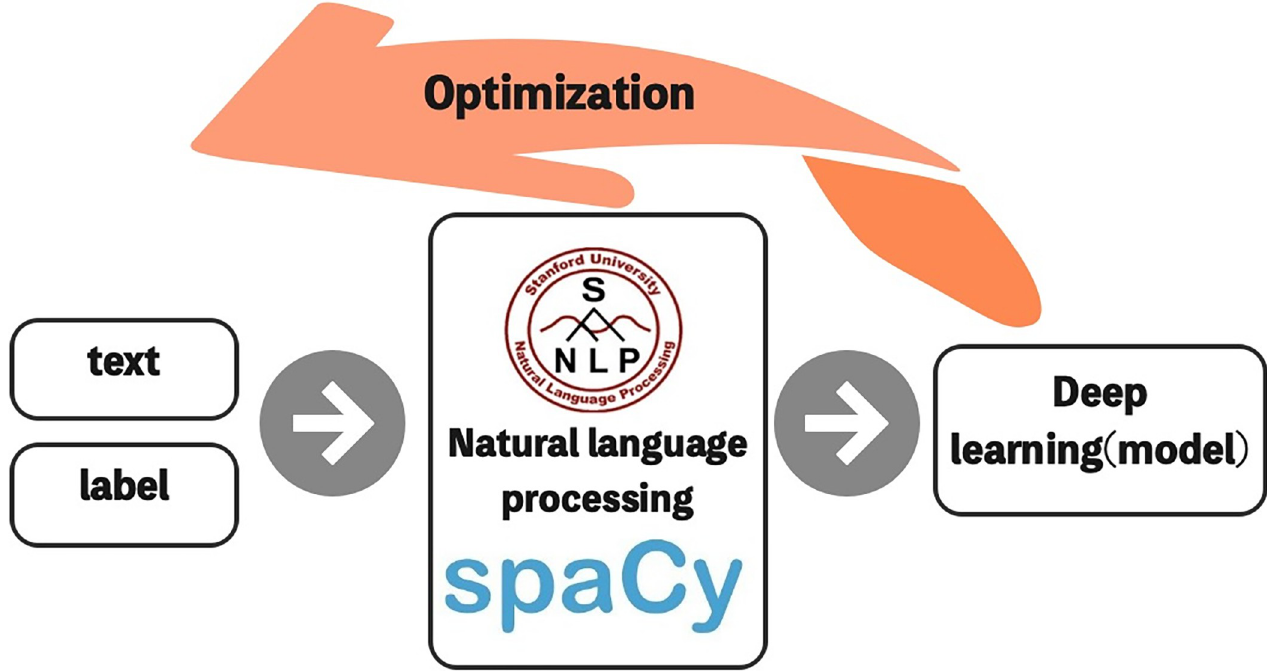
Fig 1. Training process of the international cutting-edge technology recognition model.